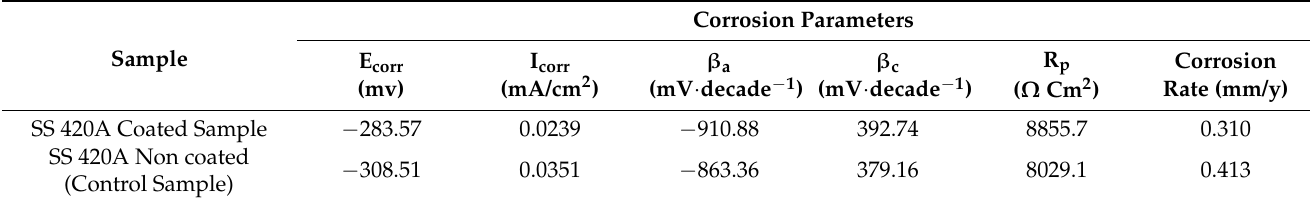
Table 7. Polarization parameters of coated and non-coated SS 420A in SBF.